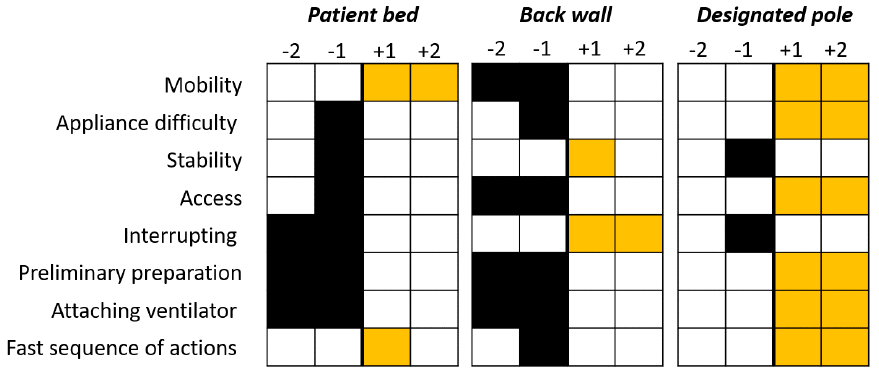
Figure 10. Using the Harris profile for concept comparison in our case